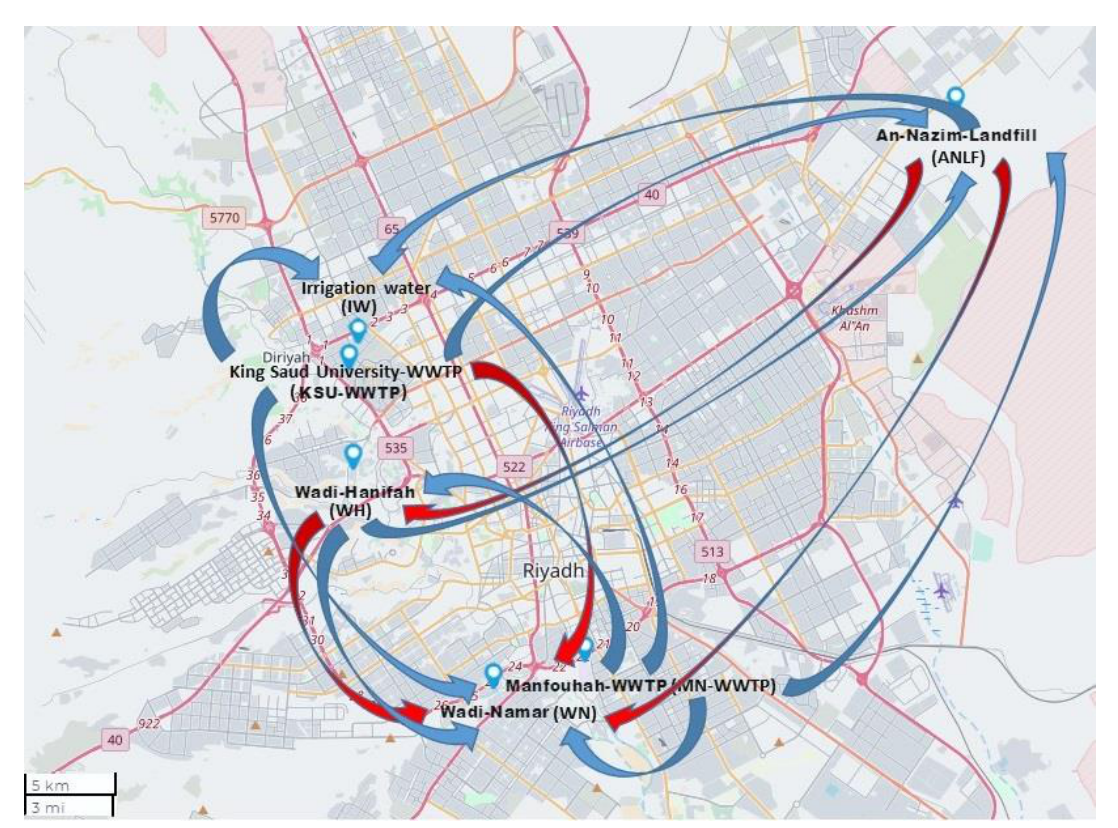
The numbers above the gray-highlighted diagonal refer to correlation values at the high-temperature range, whereas those below the diagonal are correlation values at the low-temperature range. The percentage of HAdV detectability is denoted by “% Det” at different sampling areas. For example, % Det KSU-WWTP refers to the HAdV detection percentage at KSU-WWTP. Significant correlation values are displayed as bold numbers.